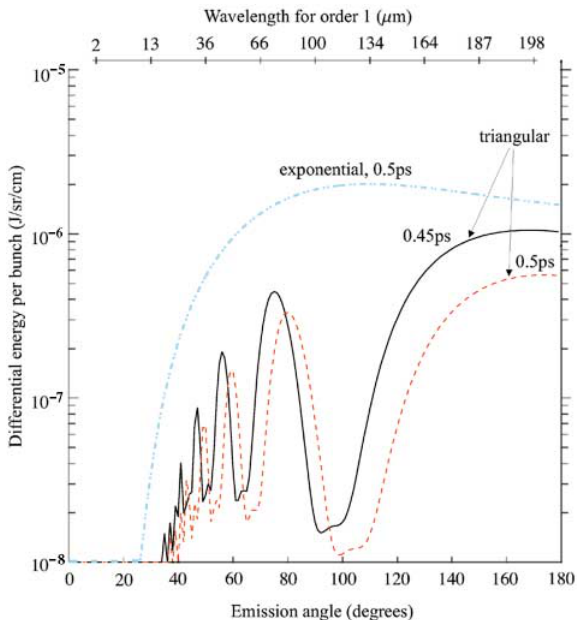
FIG. 6. (Color) Angular distribution of the radiated differen- tial energy, for various longitudinal pulse shapes (see text for